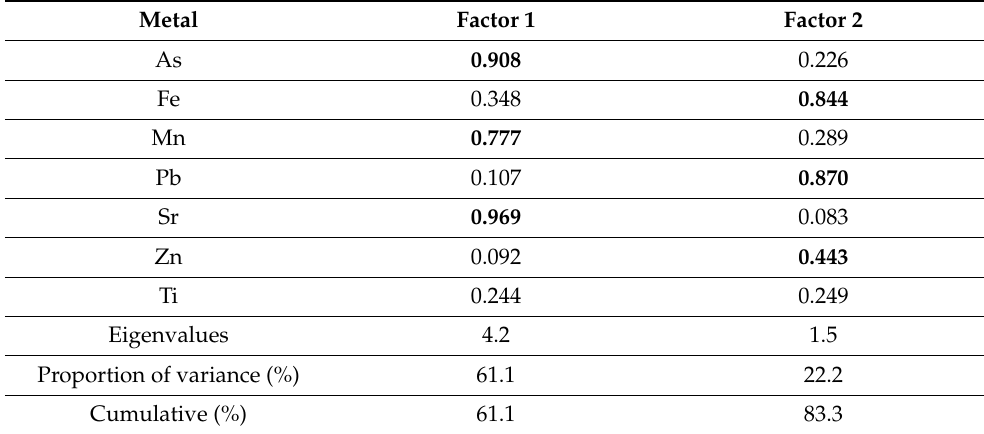
Table 4. Factor analysis results of heavy metal levels in soil.